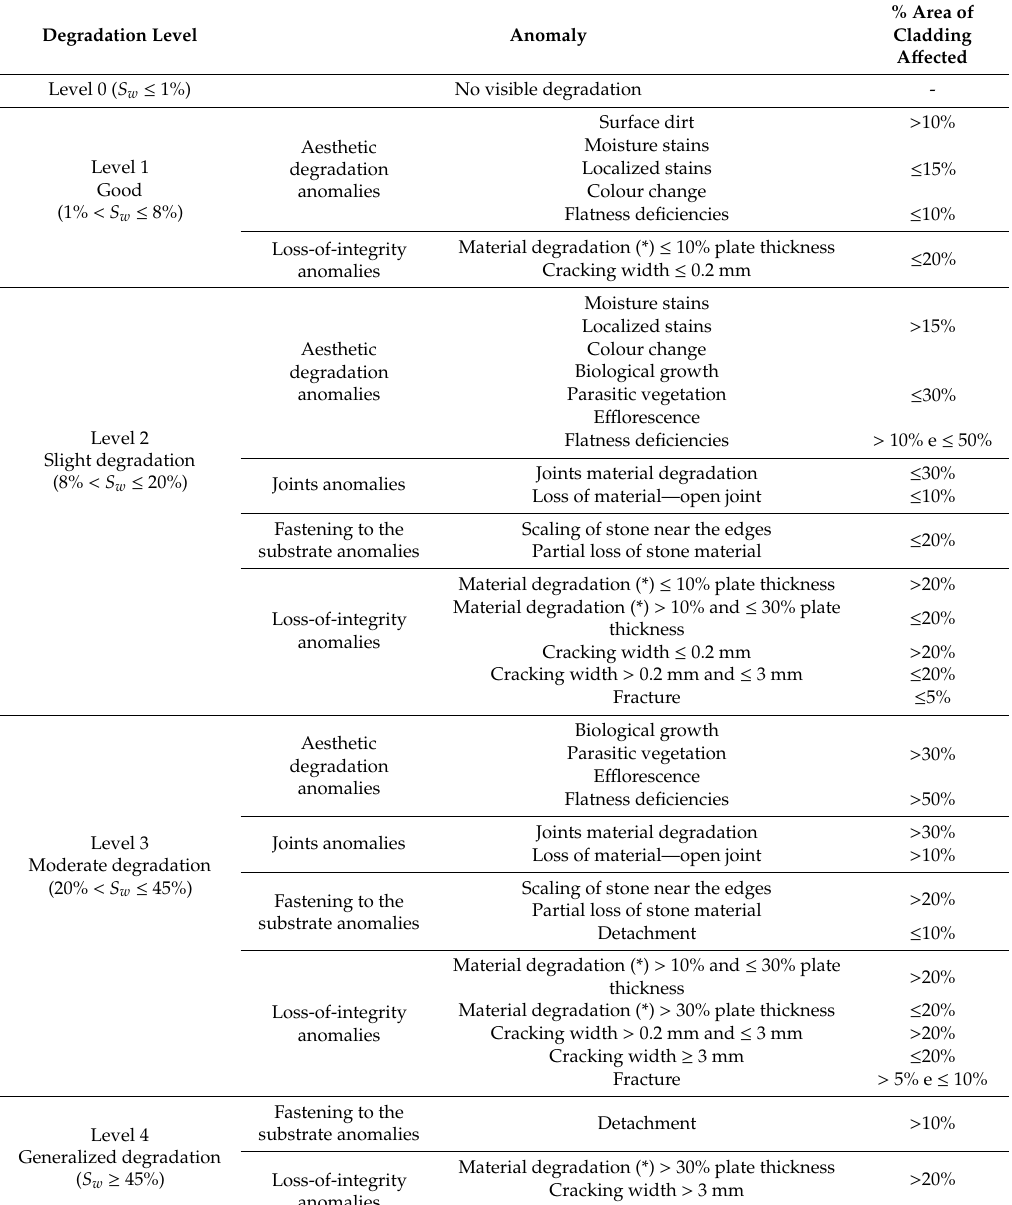
Table 1. Degradation levels for natural stone claddings (data sourced from Silva et al. [12]; Mousavi et al.